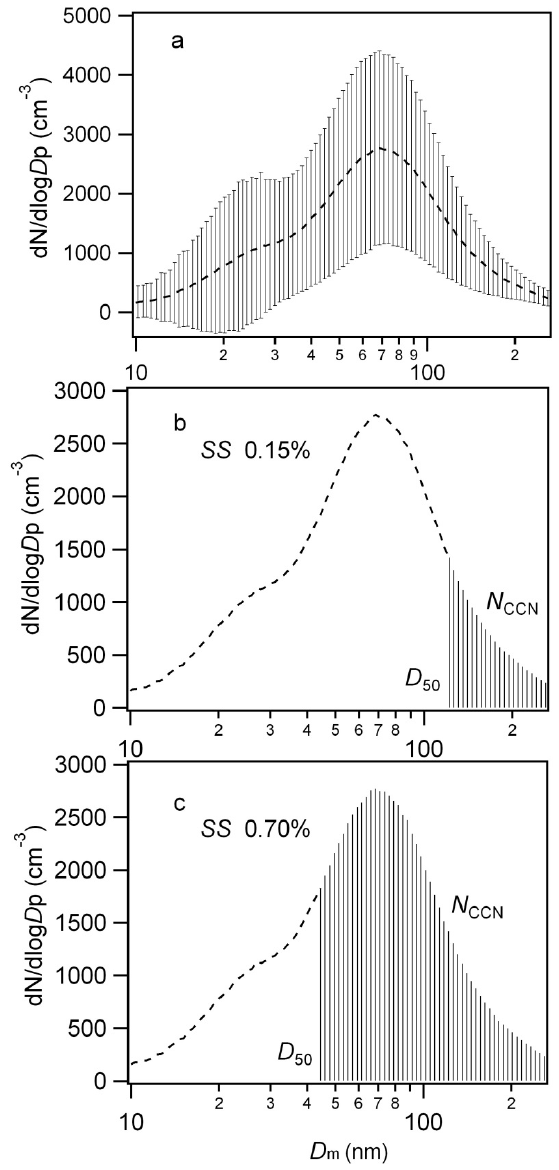
Figure 6. The average aerosol size distribution over the whole pe- riod (a) , N CCN prediction based on D 50 at SS of 0.15% (b) and 0.70% (c) . Data points are mean values and standard